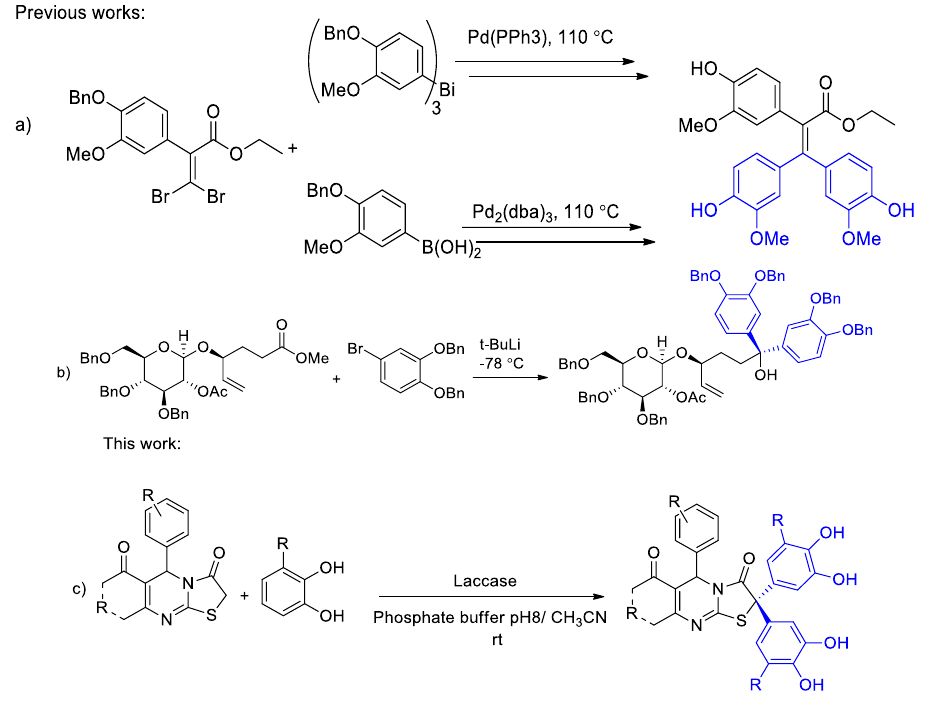
Figure 2. Previous works and this